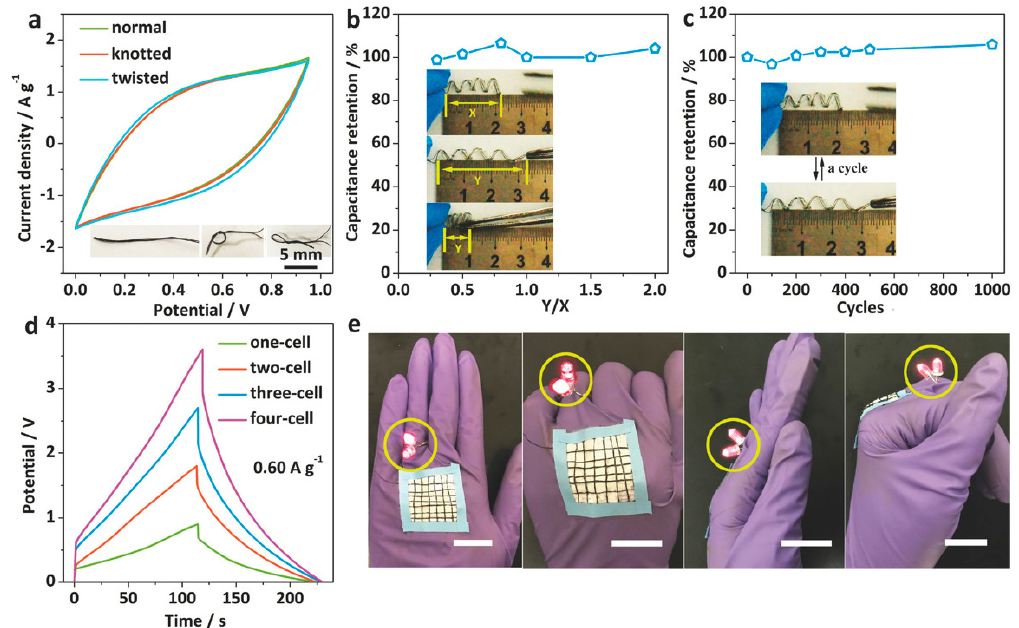
Figure 16. ( a ) CV curves of the assembled all-hydrogel-state cell in different states; ( b , c ) the elasticity of the spring-like full cell; ( d ) several full cells connected in series; ( e ) a demonstration of yarn powering two LEDs in the normal and curved states. Reproduced with permission from [143]. Wiley (2018).